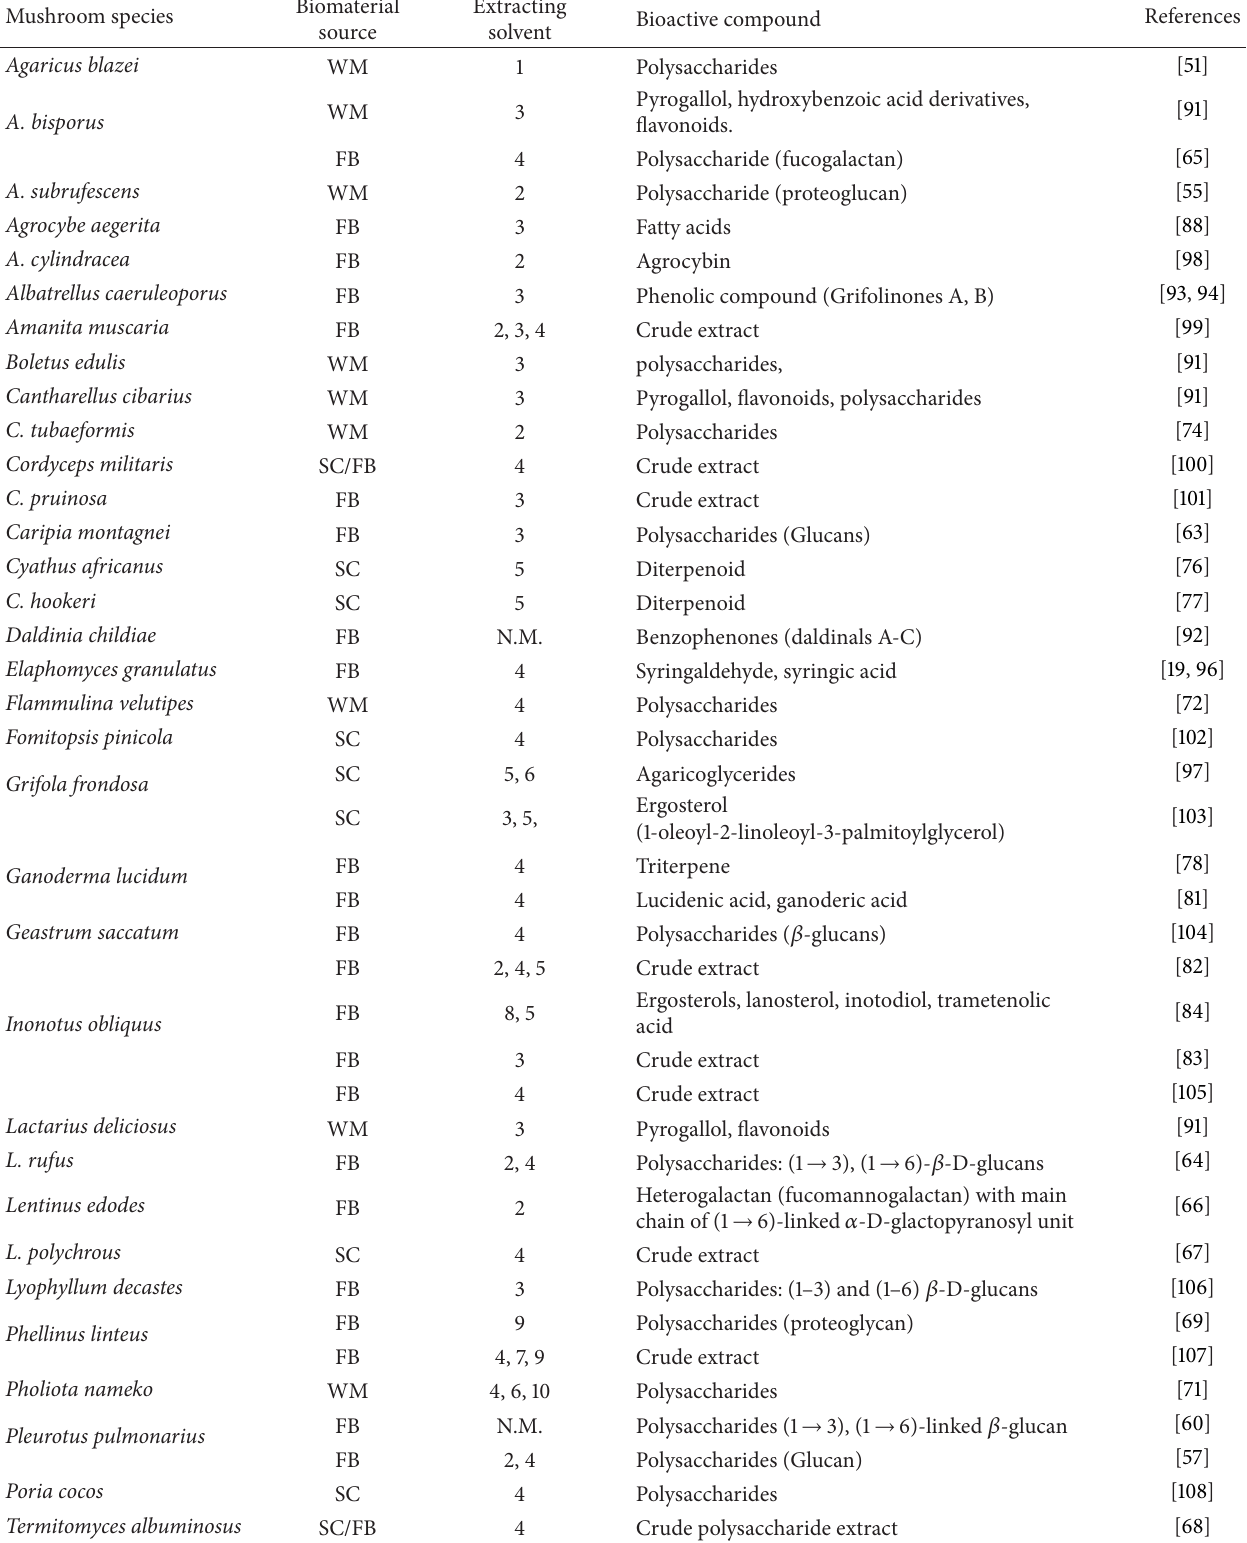
Table 1: Anti-inflammatory compounds of